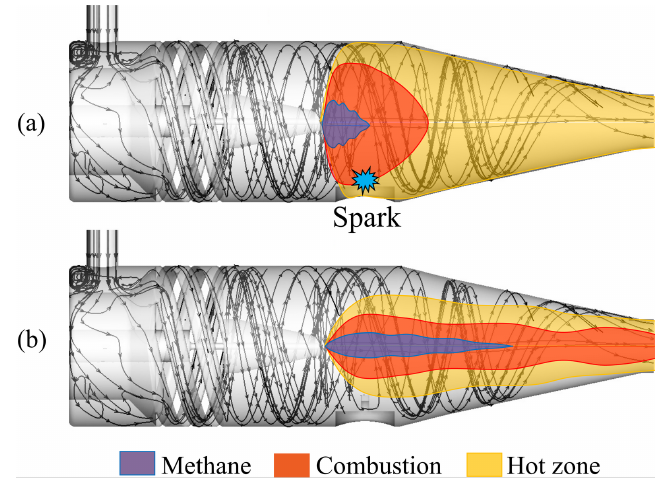
Figure 2. Ignition regimes: ( a ) Combustion initiation. ( b ) Full power flow.